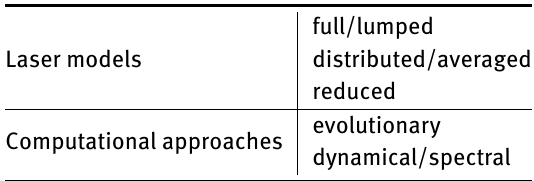
Table 1: A summary of terminology of laser models and computa- tional approaches that we use throughout this